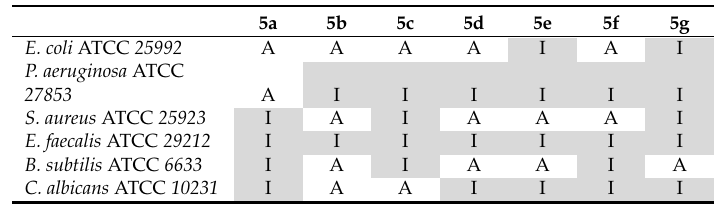
Table 3. The inhibitory activity of the new F-compounds 5a – g on the microbial biofilm development on the inert substratum (the most active compounds are